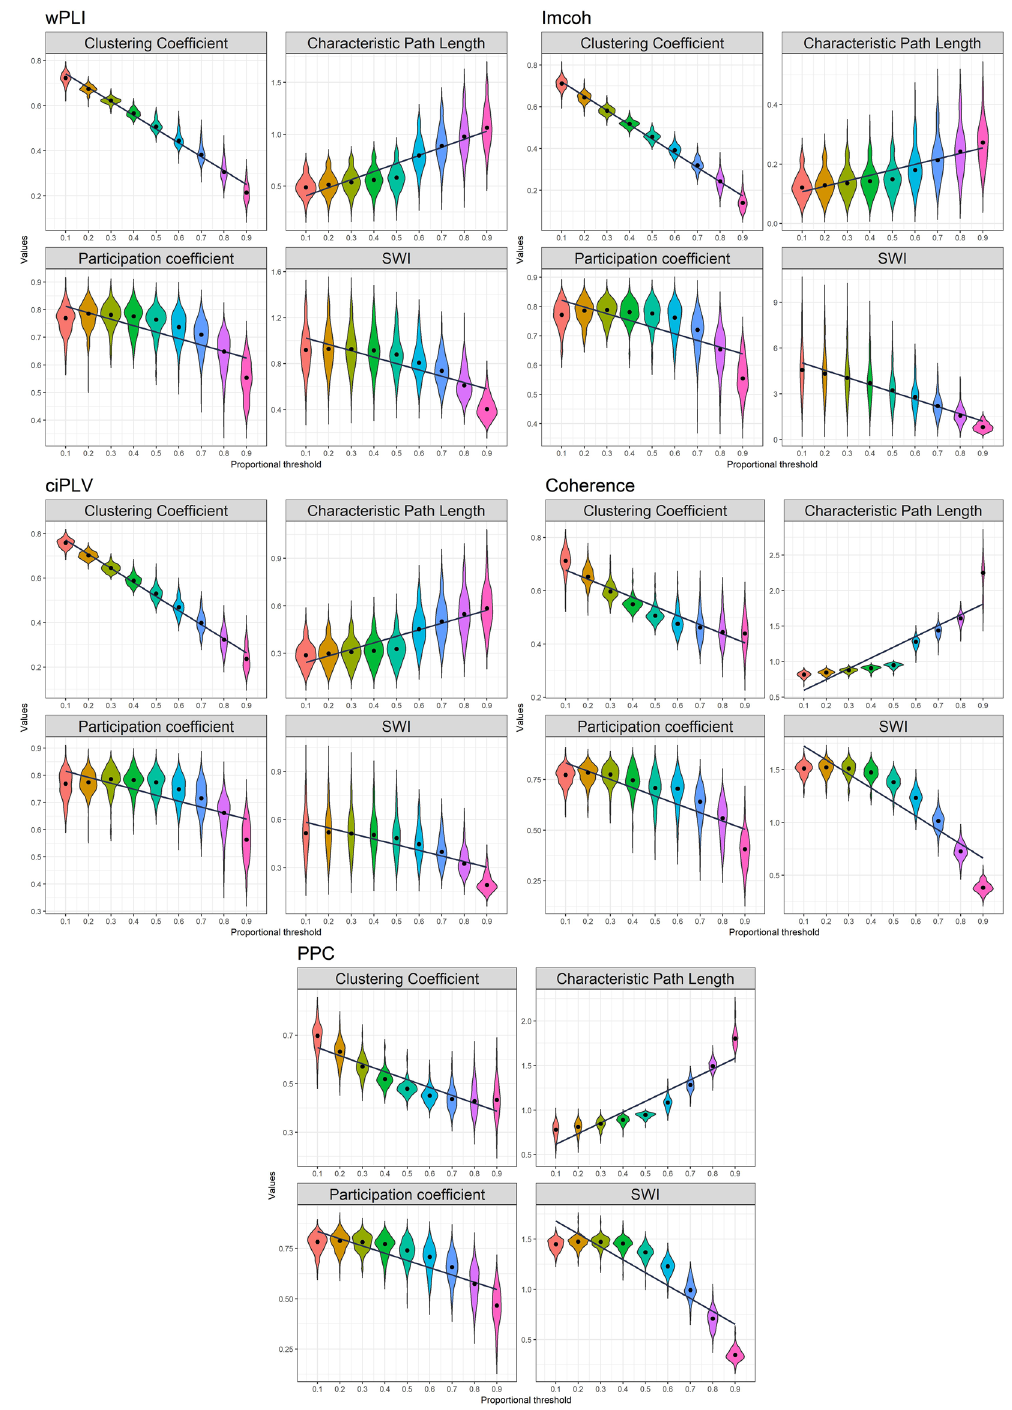
Figure 3. Effect of density thresholding on graph measures in source space. Five measures are presented in the following order (left-to-right, top-to-bottom): wPLI, imcoh, ciPLV, coherence, PPC. On each plot, four measures are presented (left-to-right, top-to-bottom): Clustering Coefficient, Characteristic PL, Participation Coefficient, SWI. The black line represents linear regression over the data. ggplot2 3.3.6 (https:// ggplo t2. tidyv erse. org/) was used to create this